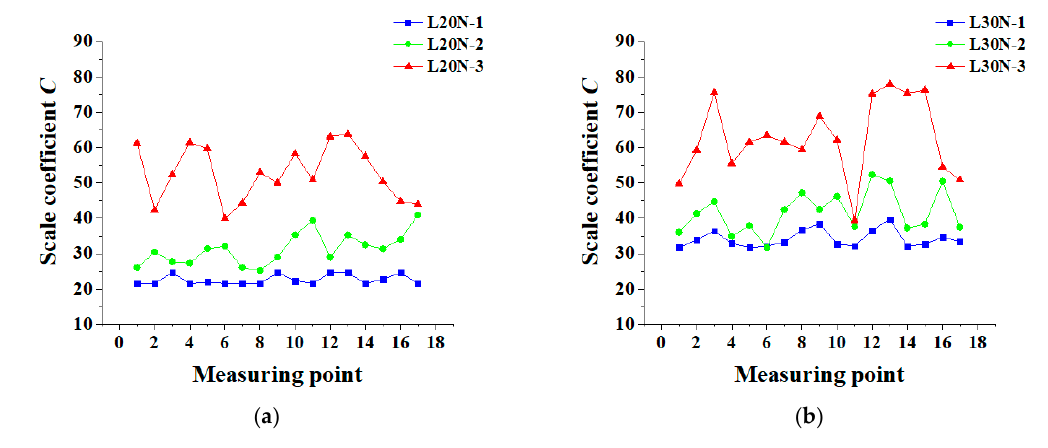
Figure 7. Variation of scale coefficient C : ( a ) L20N; ( b ) L30N.